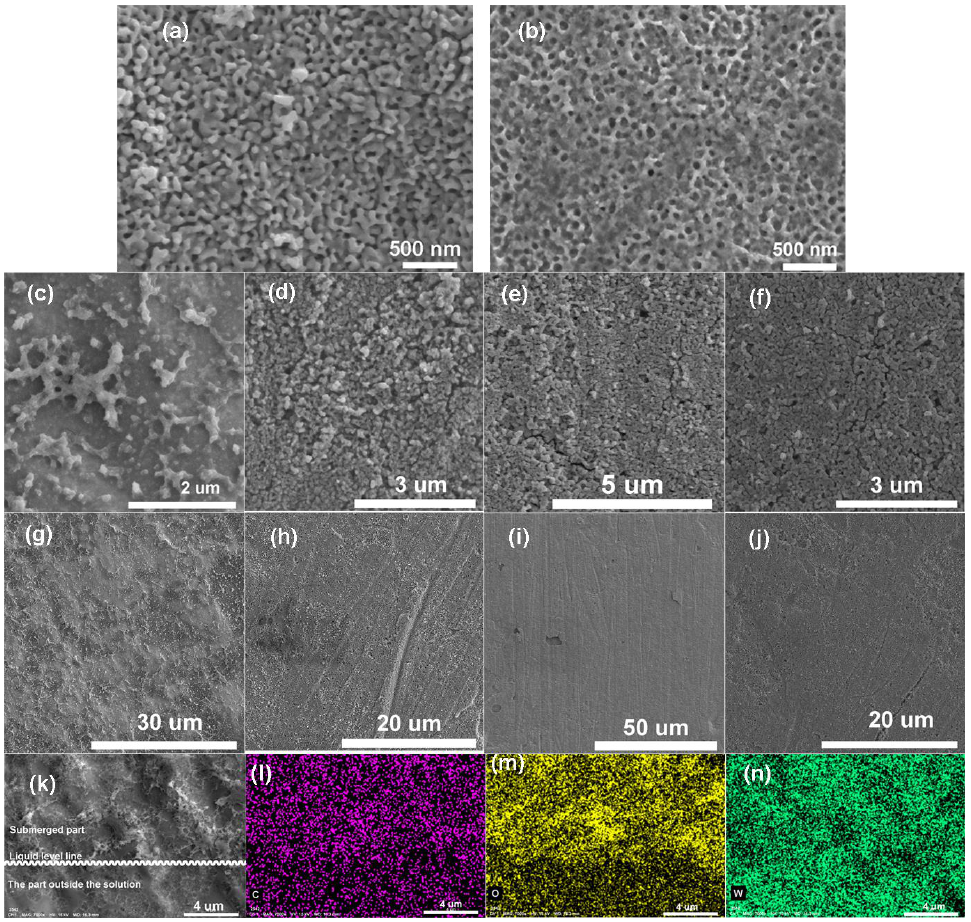
Figure 1. SEM images of ( a ) WO 3 , N-PDI-P/WO 3 after ( b ) 1 d, ( c , g ) 2 d, ( d , h ) 3 d, ( e , i ) 4 d, ( f , j ) 5 d infiltration; ( k ) SEM image of N-PDI-P/WO 3 composite sample prepared by infiltration for 1 d and EDS spectroscopy with elemental mapping of ( l ) C, ( m ) O, ( n ) W.